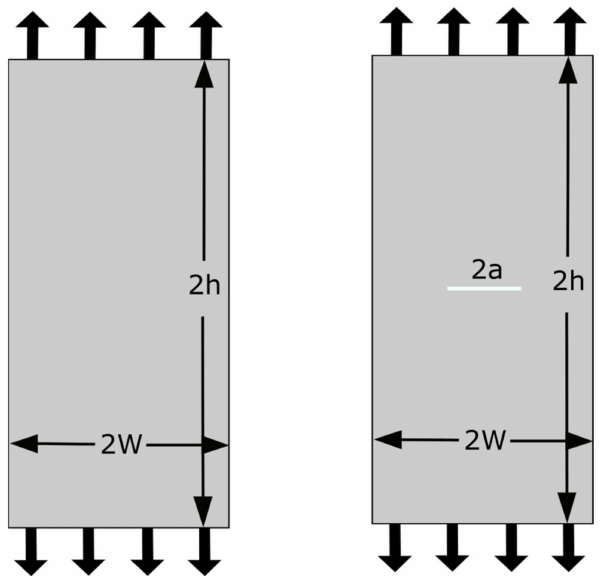
Figure 5. Specimen with center crack and without center